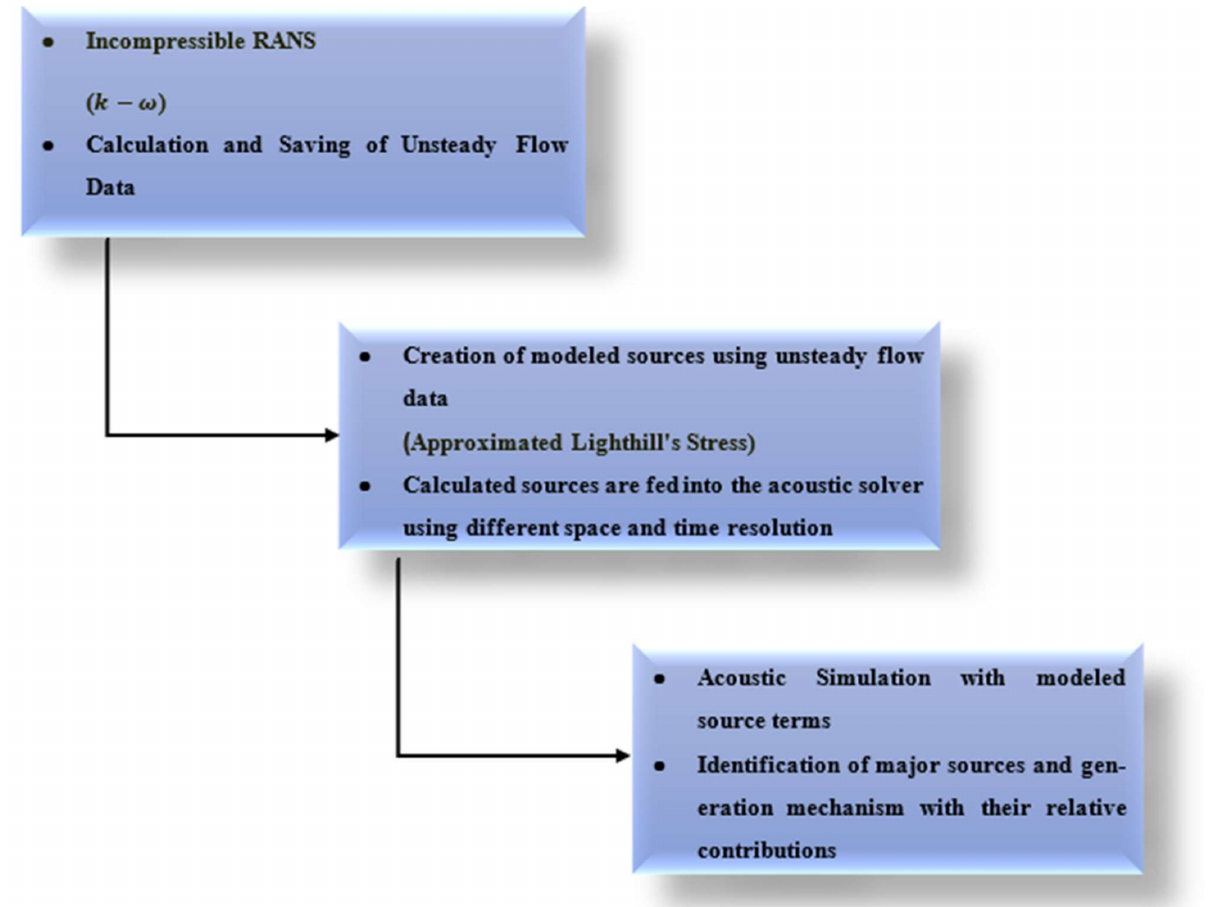
Figure 4. Numerical procedure for current computations